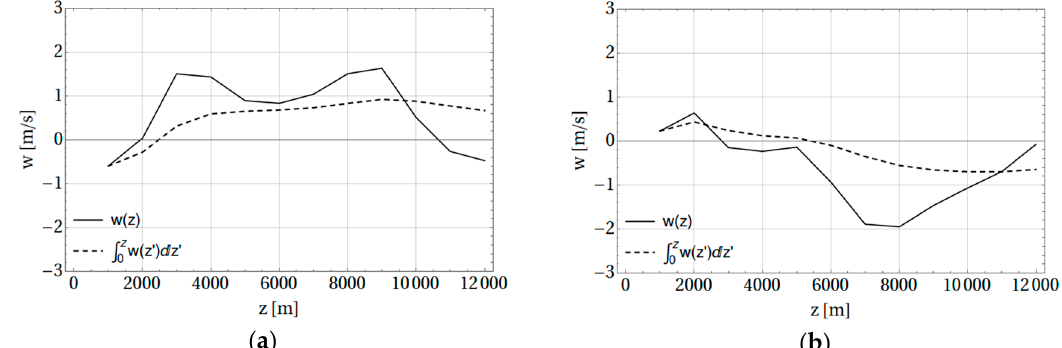
Figure 3. Wind profile of 0.3 ° × 0.3 ° ECMWF vertical wind data (centered over Athalassa). Solid line: wind speed w ; dotted line: average wind speed from ground. Data refer to 17 April 2013: ( a ) 06:00 UTC and ( b ) 12:00 UTC.